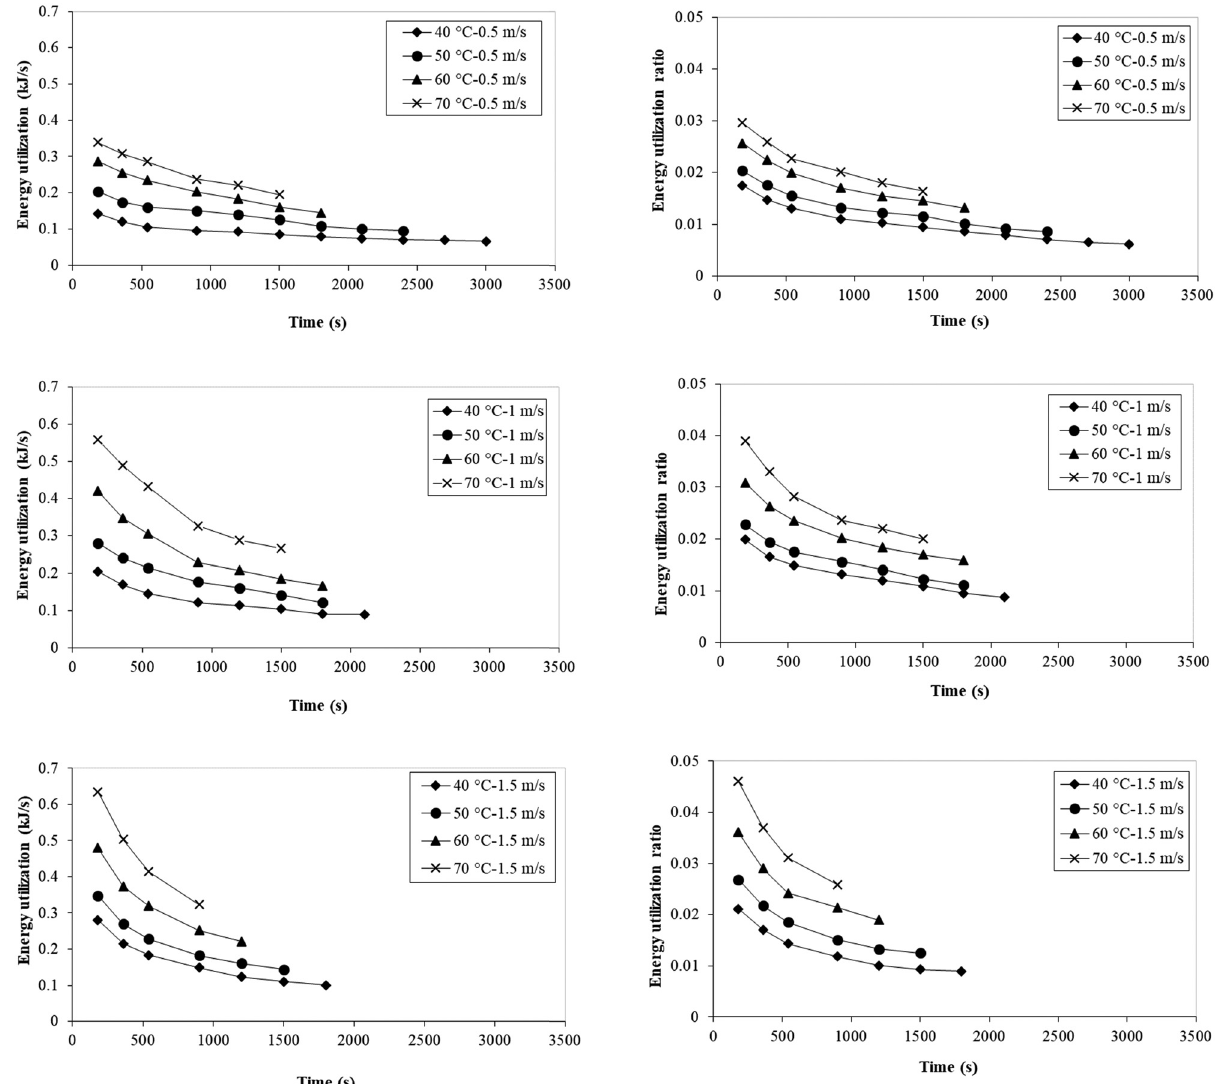
Figure 2: In fl uence of drying air temperature and fl ow rate on EU and EUR during drying of potatoes in convective